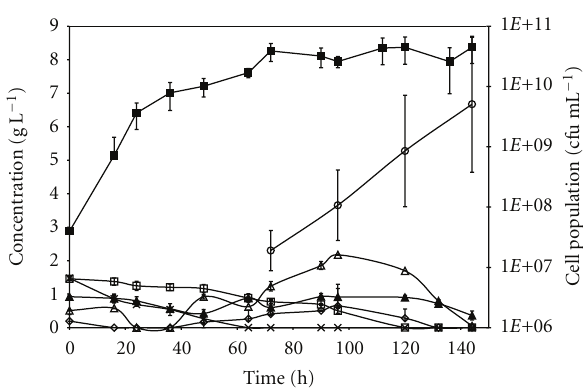
Figure 4: Acid utilization and growth of Ralstonia eutropha with continuous ARF addition. The values for cell count ( (cid:2) ), acetic acid utilization ( (cid:3) ), butyric acid utilization ( ♦ ), lactic acid utilization ( (cid:5) ), propionic acid utilization ( (cid:6) ), succinic acid utilization ( × ), and PHA concentration (O) are indicated. Values are the means of two replications with standard deviation shown by error